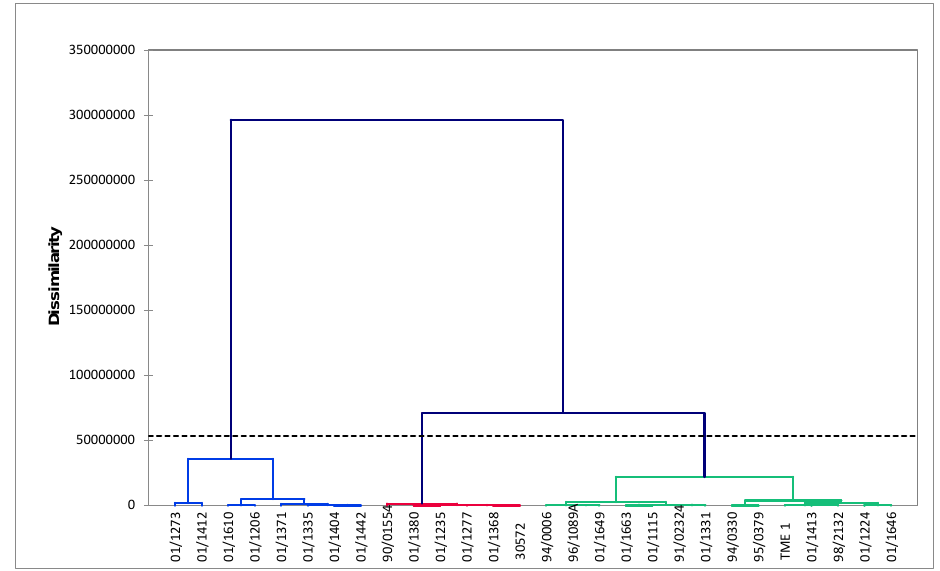
Figure 1. Dendrogram (Ward’s minimum variance clusters) showing the relationship among different cassava roots genotypes across growing locations. Table 8. Pearson correlation coe ffi cients of trace and macro elements of yellow-fleshed cassava roots across genotypes and growing